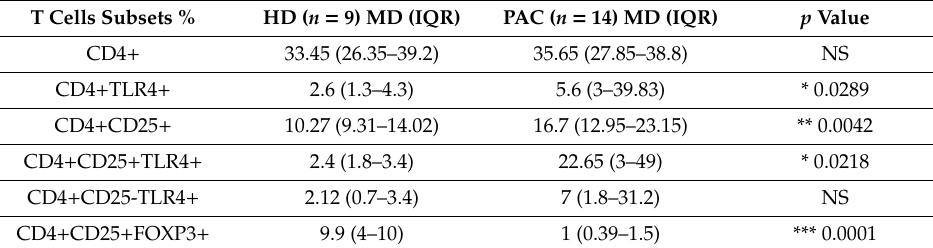
Table 2. Percentages of the T cell subsets in both study groups.